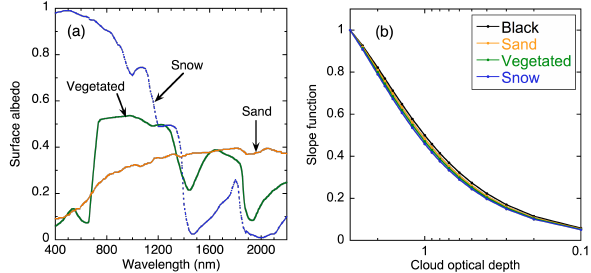
Fig. 2. (a) Spectral surface albedo values used in SBDART simu- Figure 2. (a) Spectral surface albedo values used in SBDART simulations for sand, vegetated, 3 lations for sand, vegetated, and snow surfaces, plotted by orange, and snow surfaces, plotted by orange, green, and blue lines, respectively. (b) Correpsonding 4 green, and blue lines, respectively. (b) Corresponding slope func- slope functions, derived from 400–870 nm, depend on cloud otpical depth and underlying surface 5 tions, derived from 400–870nm, depend on cloud otpical depth and underlying surface types. 6